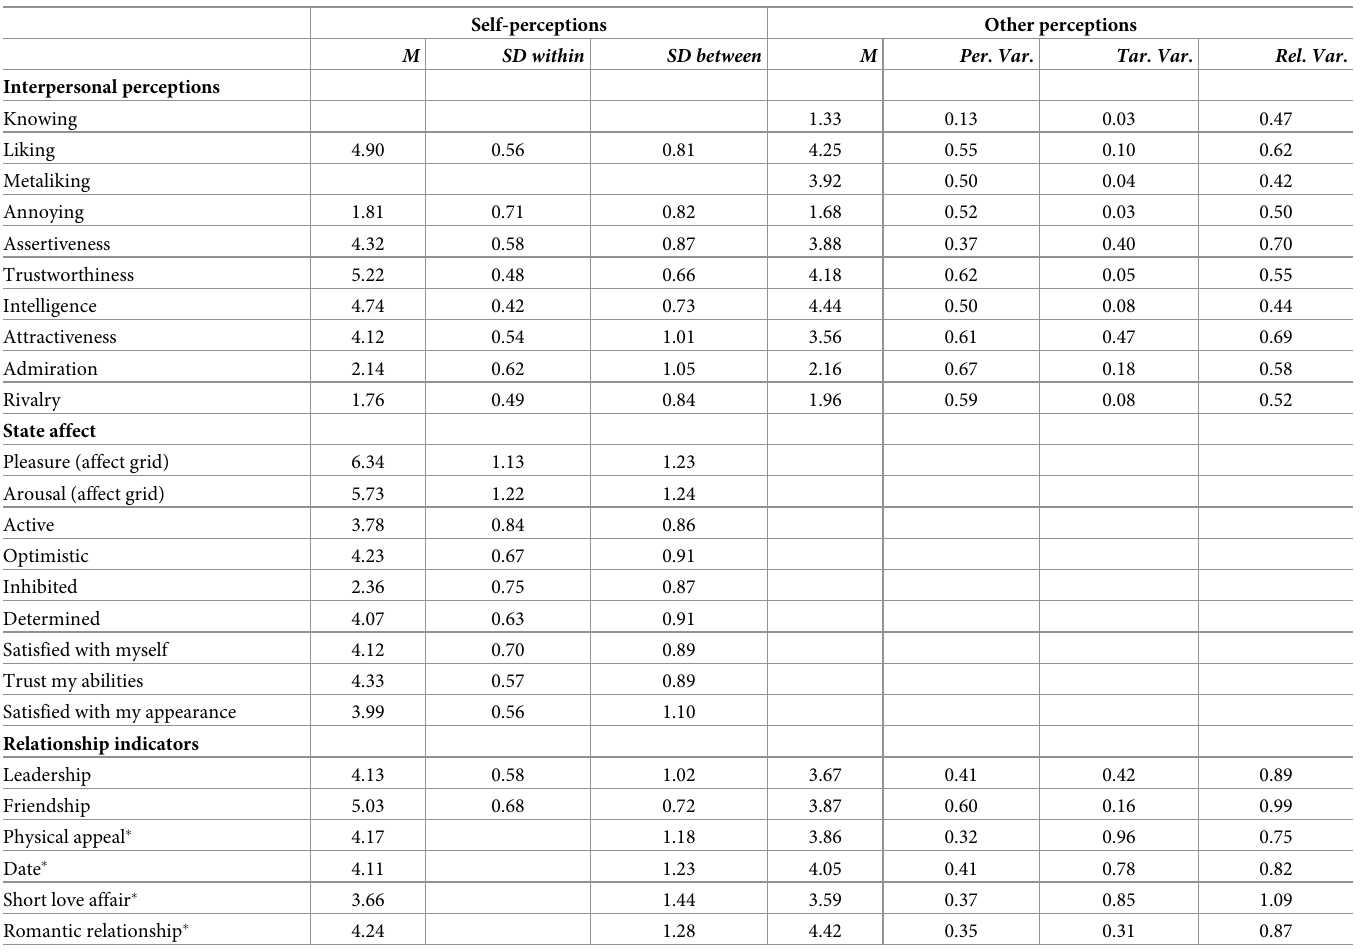
Table 7. PILS session results (self-ratings, interpersonal